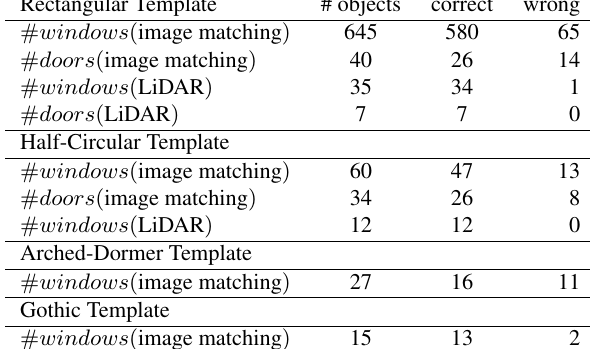
Table 2: Results of our experiments conducted on different data sets using the four templates for windows and doors. The number of correct versus wrong localizations for 20 data sets of point clouds of